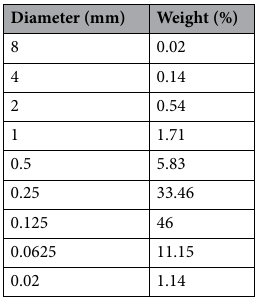
Table 1. Ash particle size distribution reported by Coltelli et al. 11 .